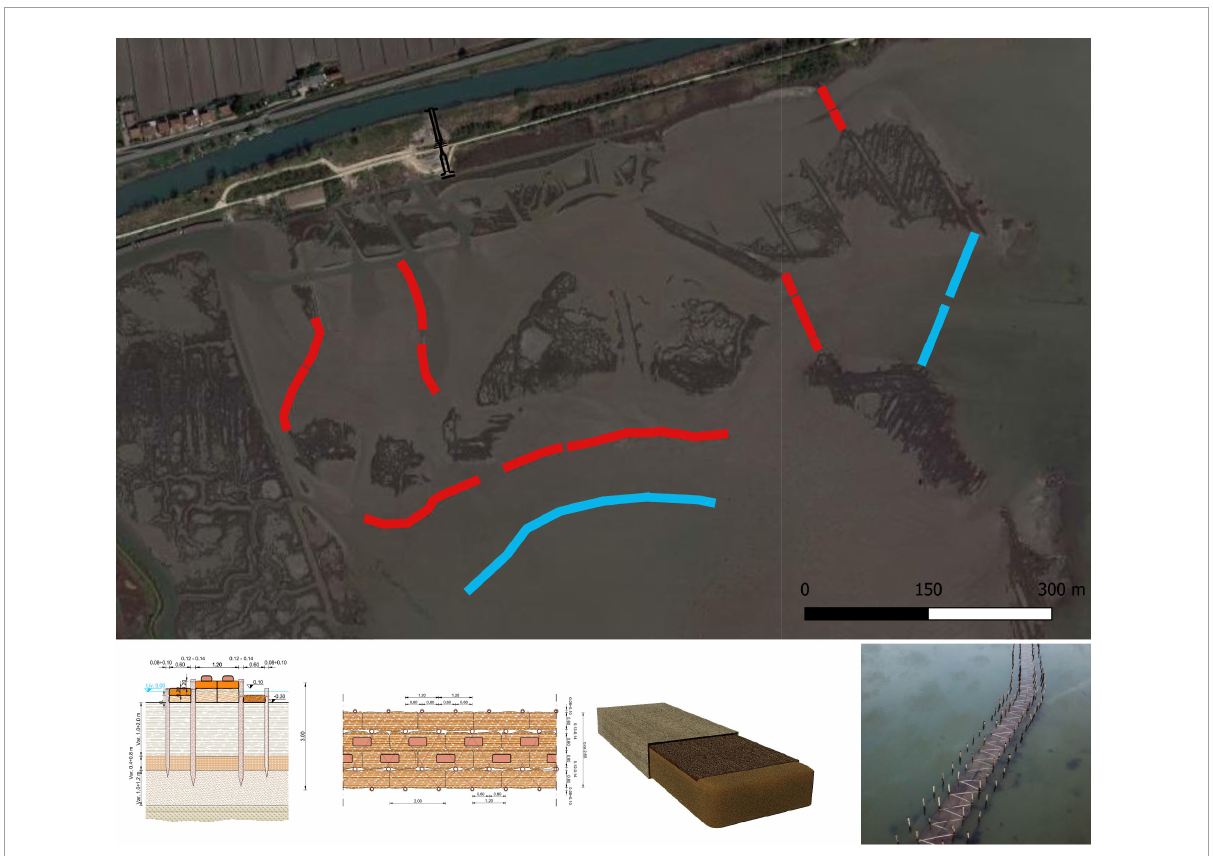
FIGURE5 Morphological works. Top : in red first phase and in blue second phase. Bottom : executive design of morphological works, biodegradable module and frame of completed morphological